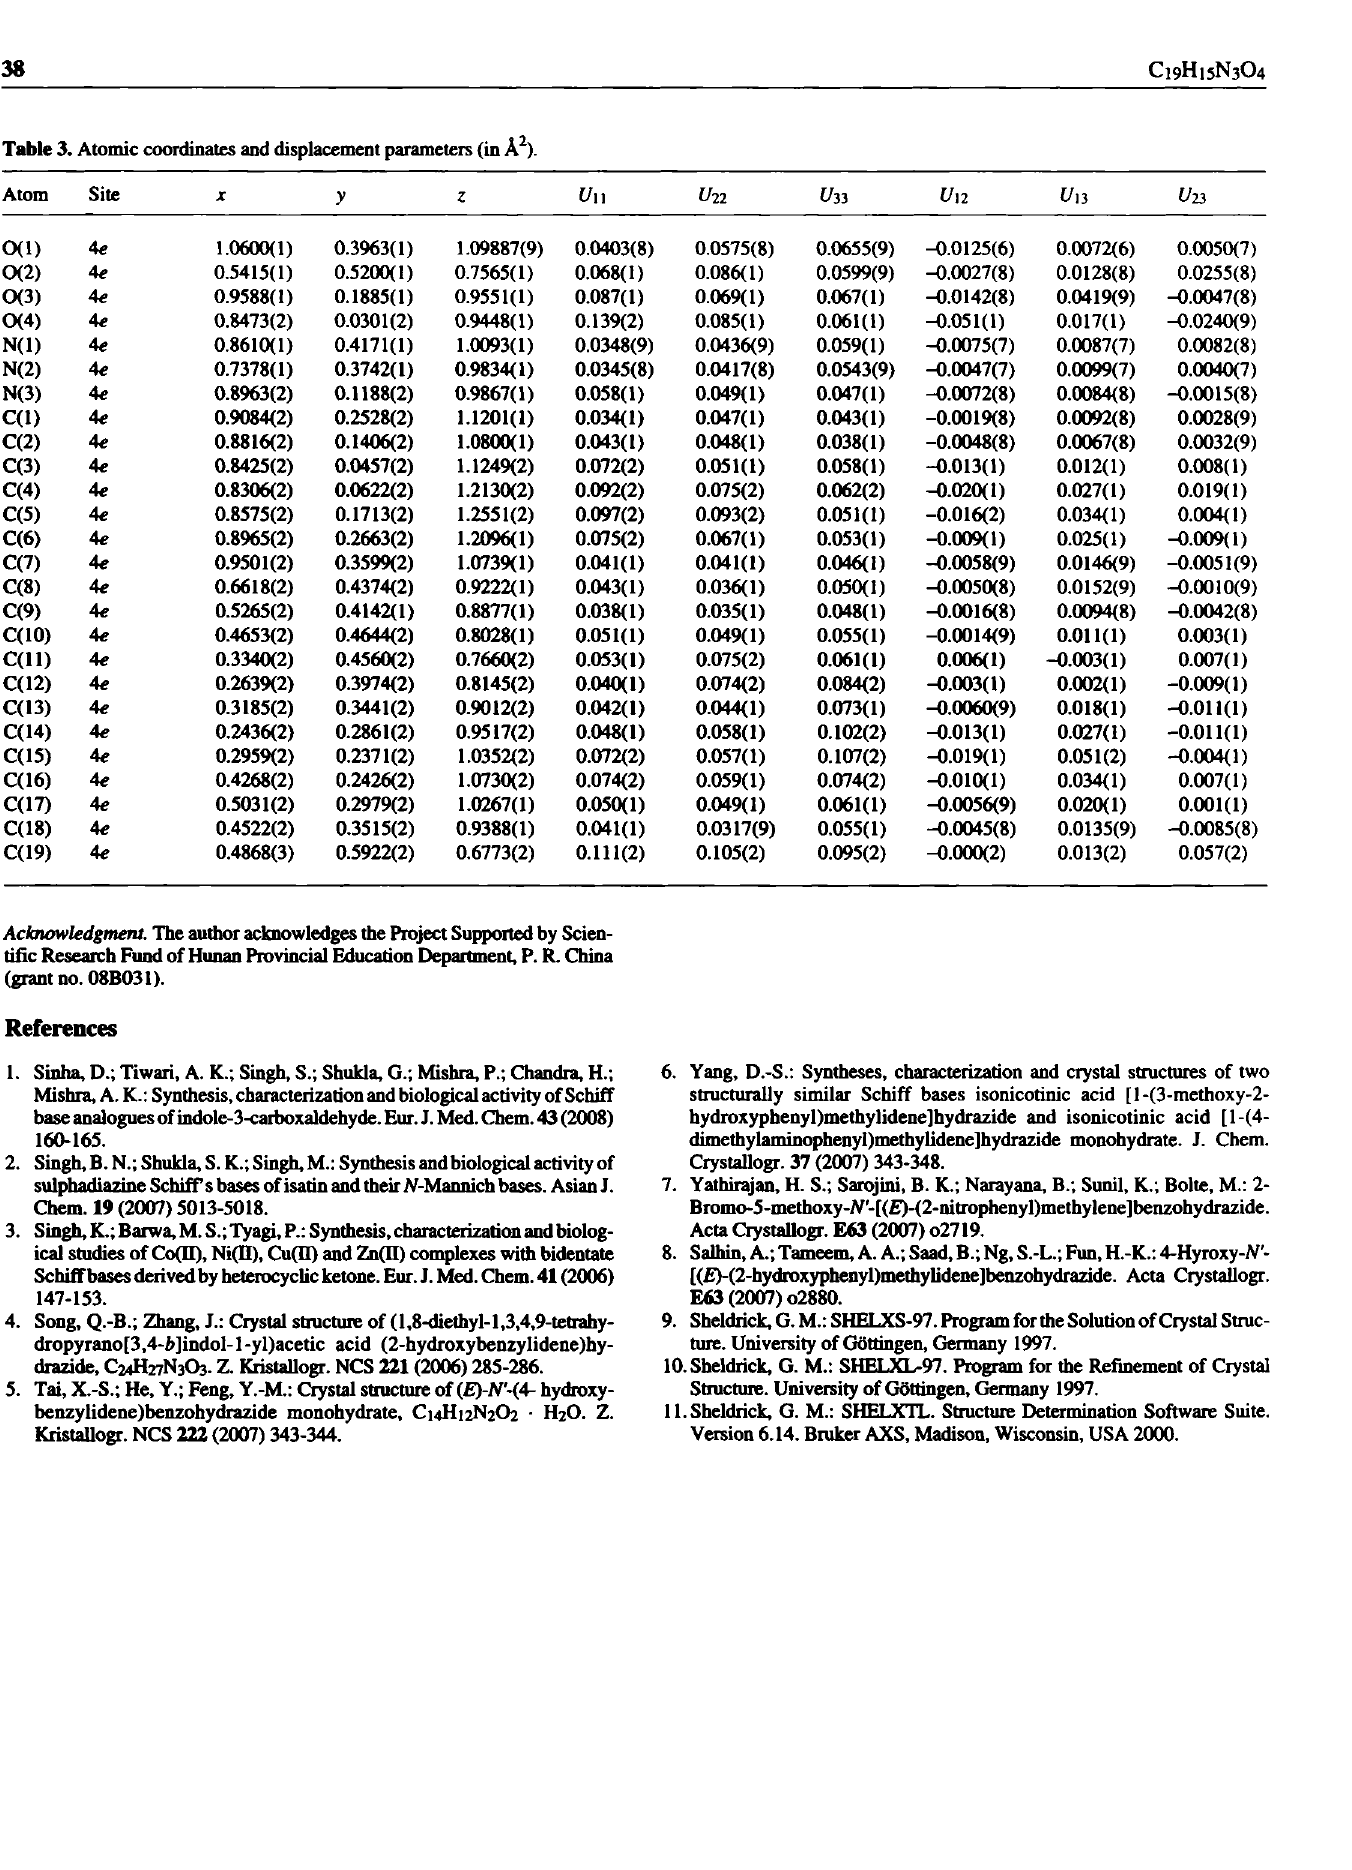
Table 3. Atomic coordinates and displacement parameters (in Â 2